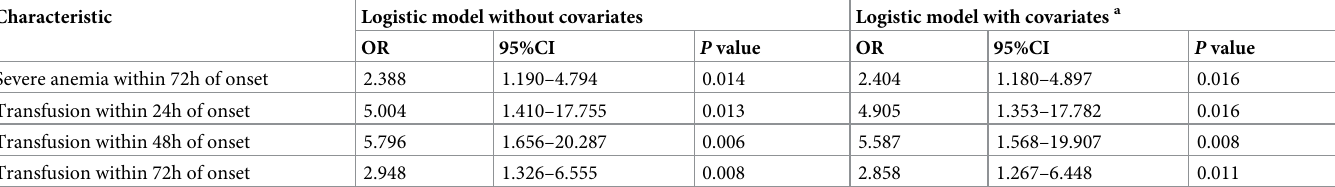
Table 4. Univariate and multivariate logistic analysis for NEC in very low birth weight infants.